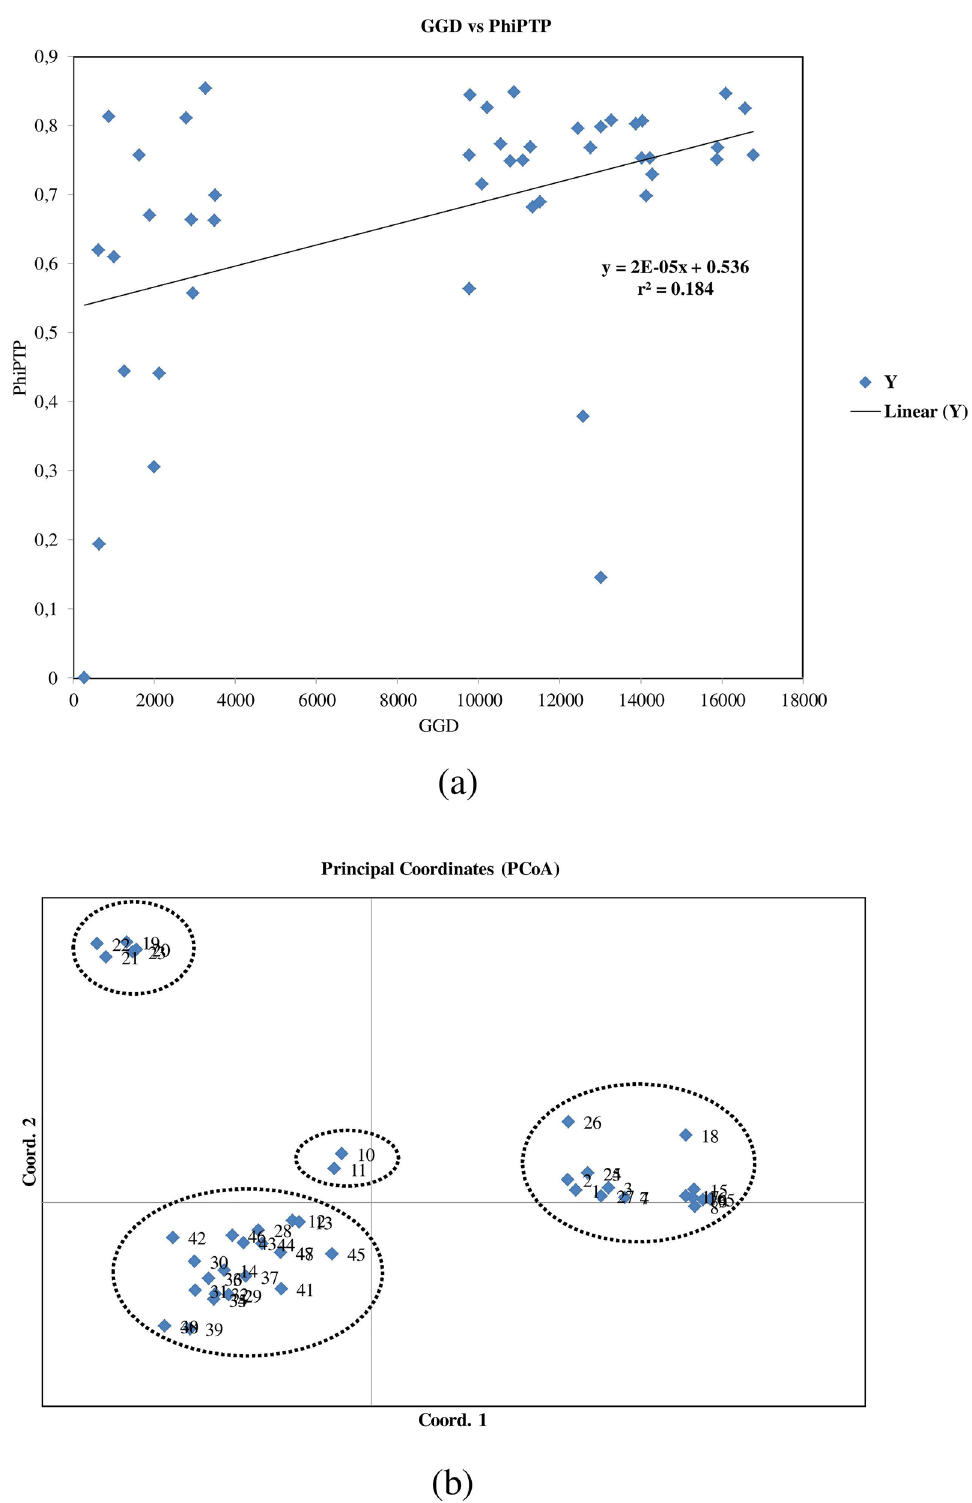
Figure 1. ( a ) Graph representing test of correlation between genetic and geographic distance among 48 individuals of Dactylorhiza hatagirea . ( b ) Graph representing Principal Coordinate Analysis (PCoA) of genetic differences among 48 individuals of Dactylorhiza hatagirea